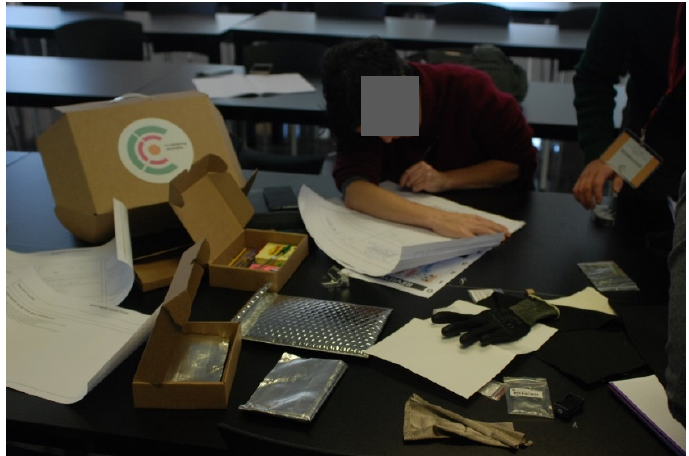
Figure 15. Participants from Group 1 completing the templates. Sensors 2020 , 20 , x FOR PEER REVIEW